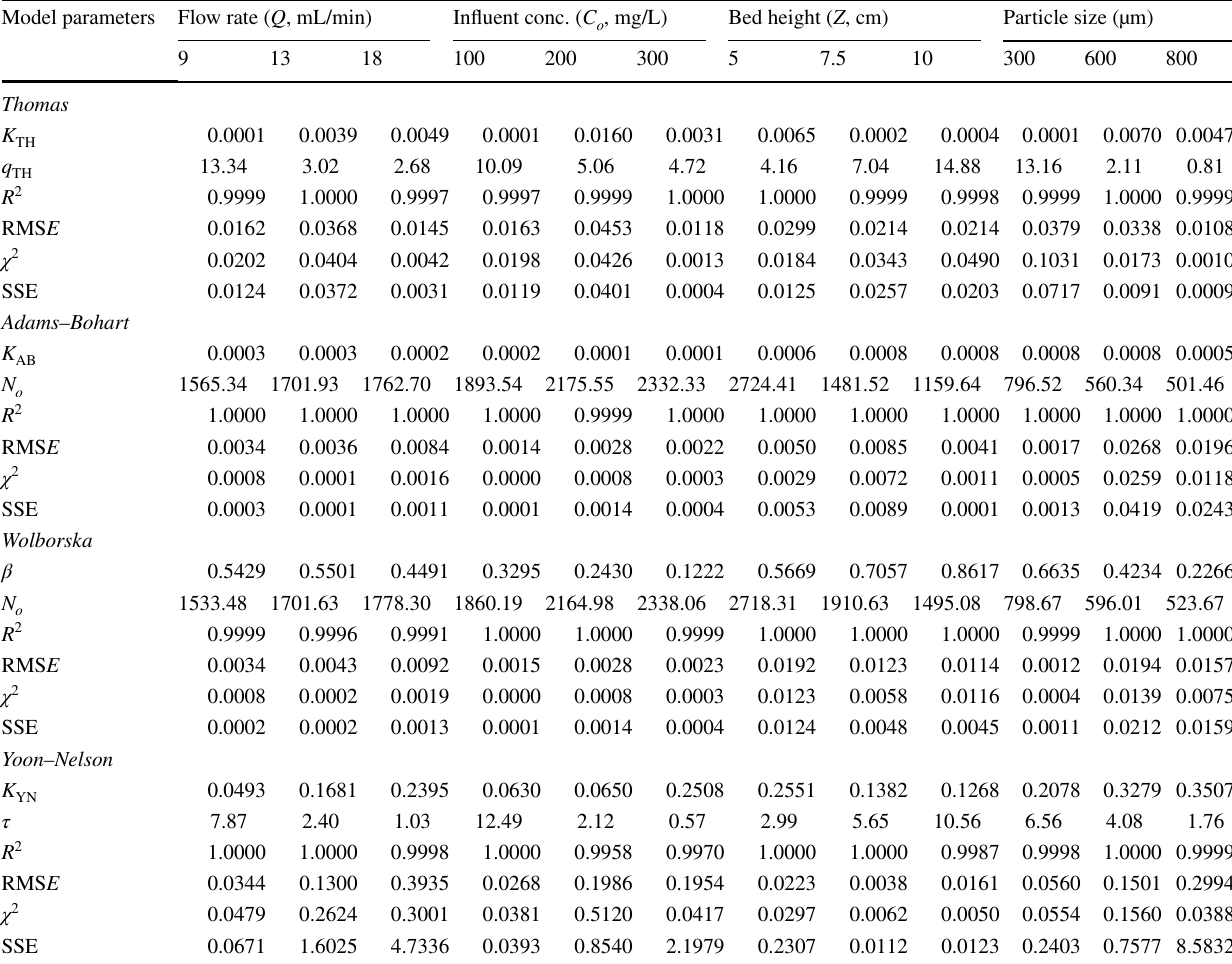
Table 8 Kinetics parameters obtained via nonlinear regression Model parameters Flow rate ( Q , mL/min) Influent conc. ( C o ,